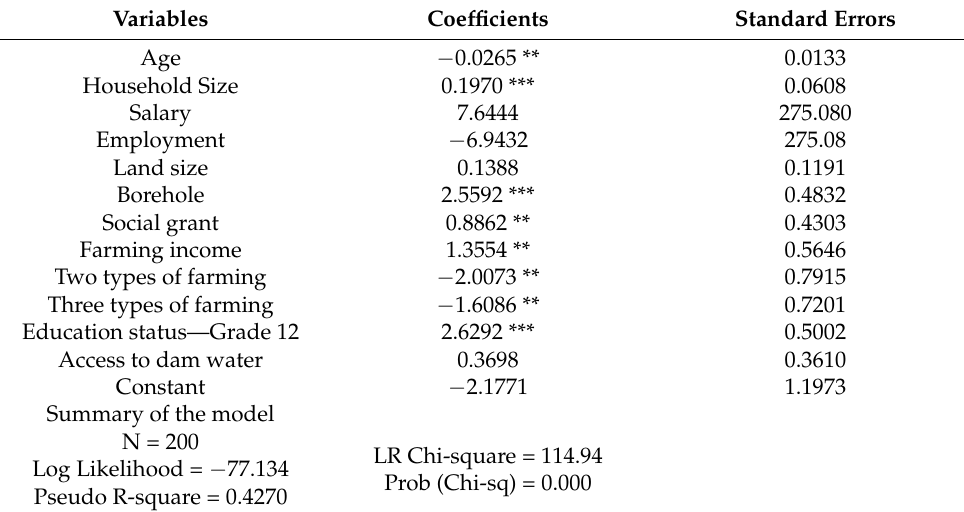
Table 1. Determinants of capacity building of smallholder farmers towards climate